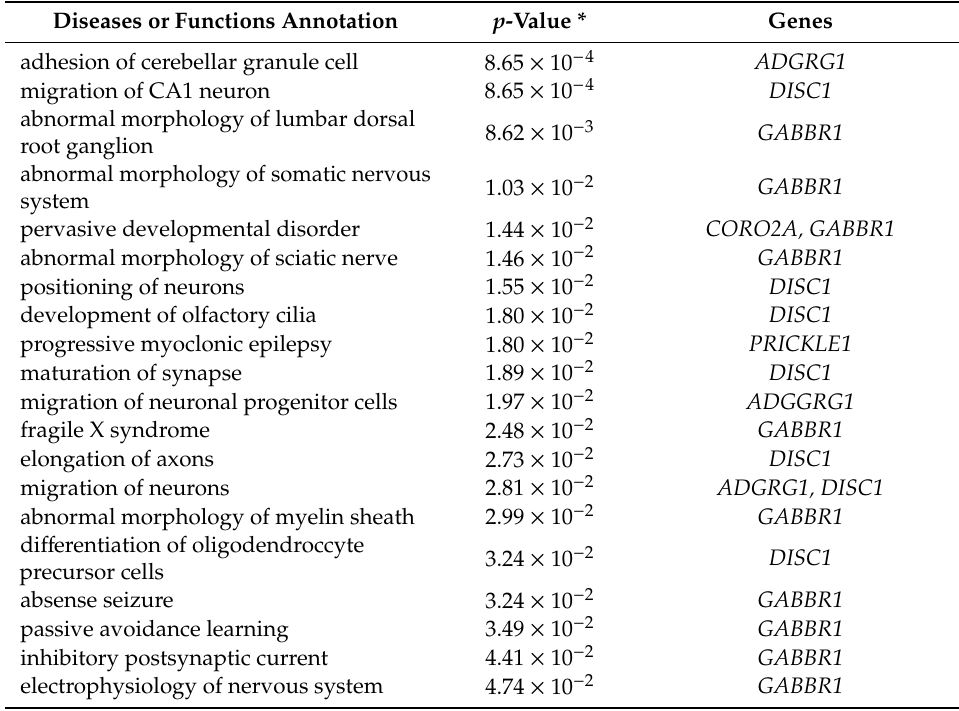
Table 10. Neurological functions implicated by QTN-associated genes in dNA.DZ.